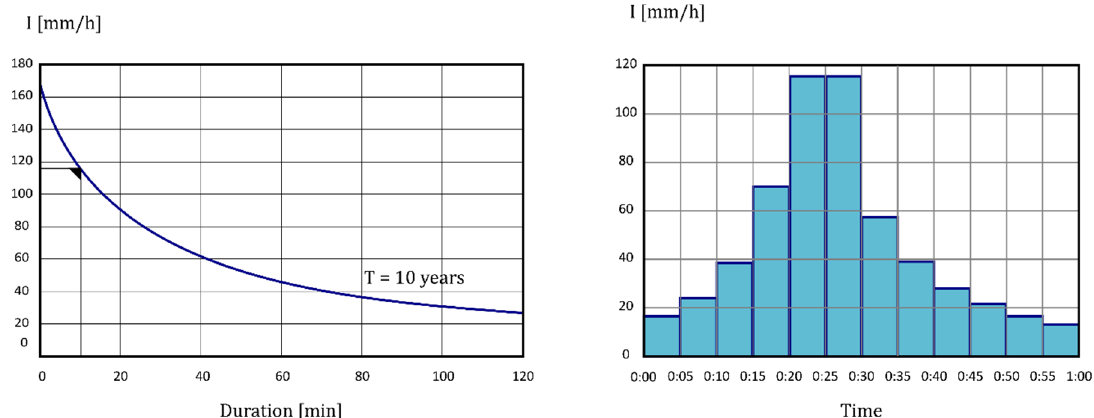
Figure 4. Rainfall used in the case study ( left : intensity–duration–frequency (IDF) curve for a return period of 10 years, right : design storm).